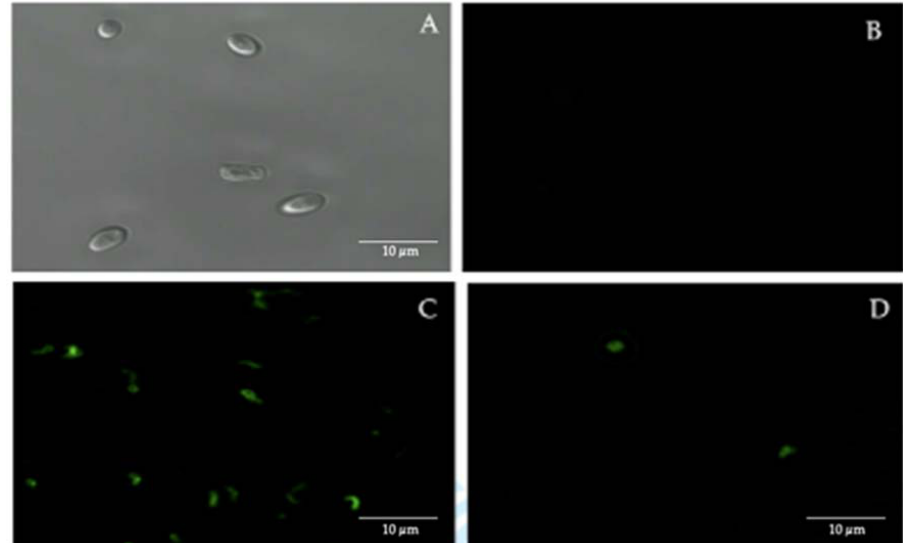
Figure 2. Immunofluorescence assay using fluorescein isothiocyanate (FITC)-labeled anti- H. pylori IgG polyclonal antibodies. ( A ) bright field microscopy of C. albicans ATCC 90028 strain (negative control). ( B ) C. albicans ATCC 90028 strain (negative control) showing the absence of fluorescence. ( C ) H. pylori ATCC 43504 strain (positive control) showing fluorescence. ( D ) fluorescent intracellular H. pylori within yeast cells isolated from the vaginal discharge sample, cultured in Sabouraud agar supplemented with chloramphenicol, of a term pregnant woman. Micrograph D is a representative image of one of the triplicates of one of the vaginal discharge samples positive for the presence of intra-yeast H.